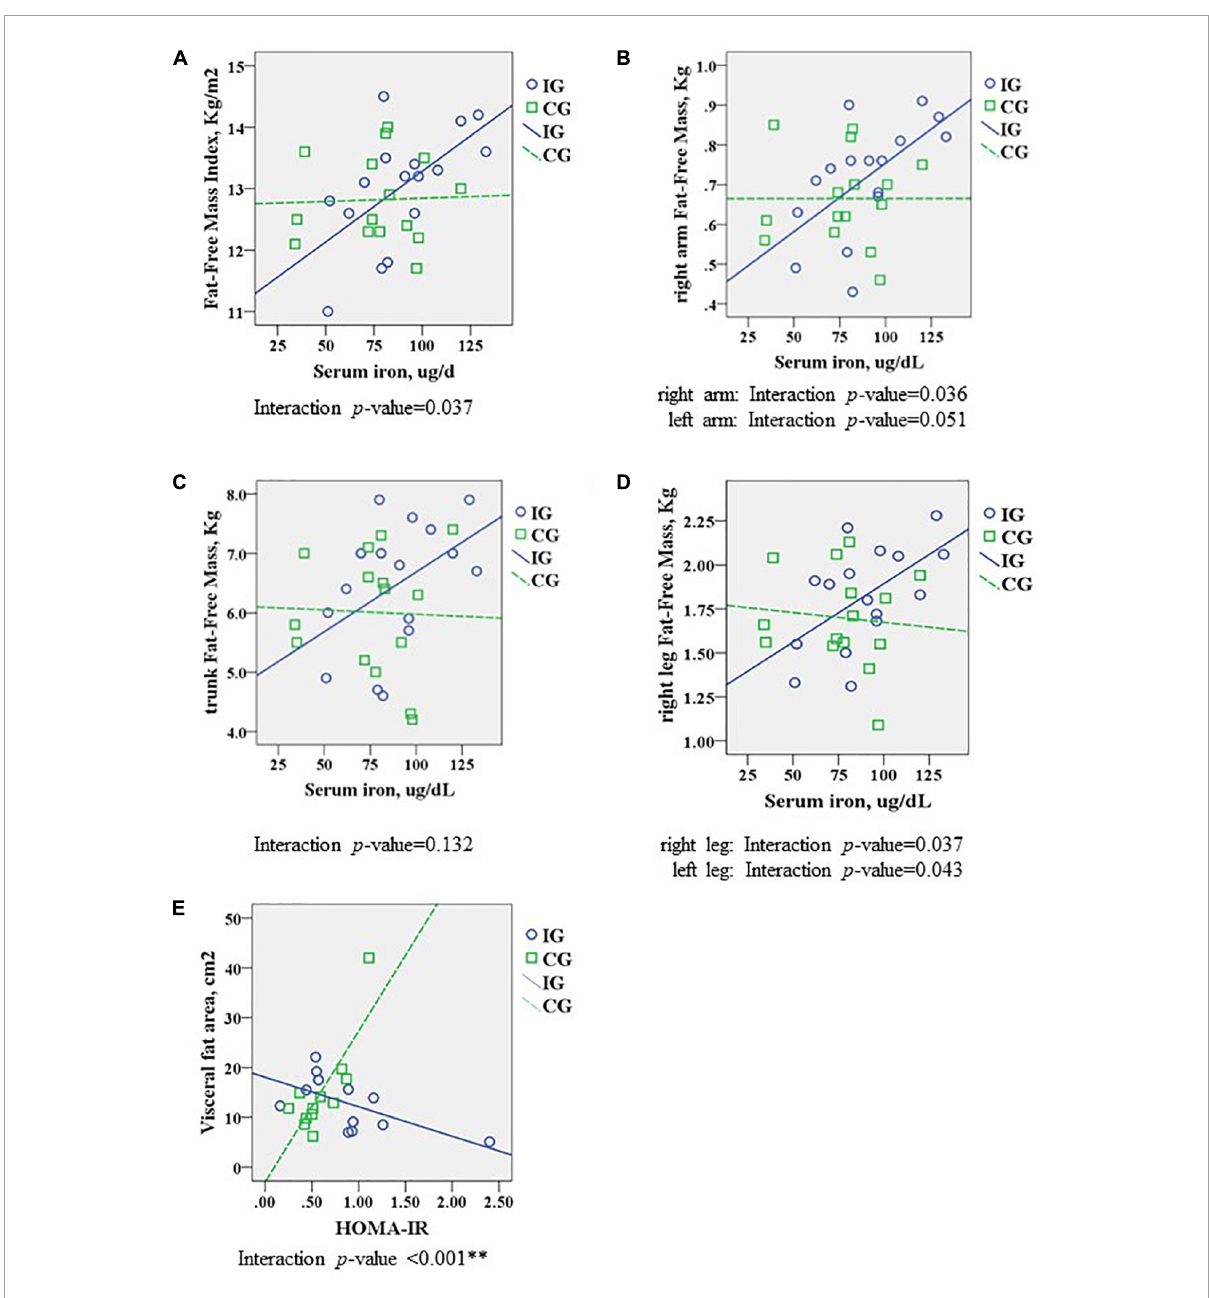
FIGURE2 Comparison of body composition analysis at preschool age between interventional group (IG) and conventional group (CG), analyzing the interaction with biochemical blood results (blood exam at 24 months of corrected age), adjusted by gender. Association of (A) FFM Index and serum iron, (B) right arm FFM and serum iron, (C) trunk FFM and serum iron, (D) right leg FFM and serum iron, and (E) visceral fat area and HOMA-IR. Data were analyzed using ANCOVA, presenting interaction significant with a p -value < 0.05. FFM, fat-free mass; HOMA-IR, homeostatic model assessment for insulin resistance. ∗∗ Removing the two outliers, interaction is still significant ( p =